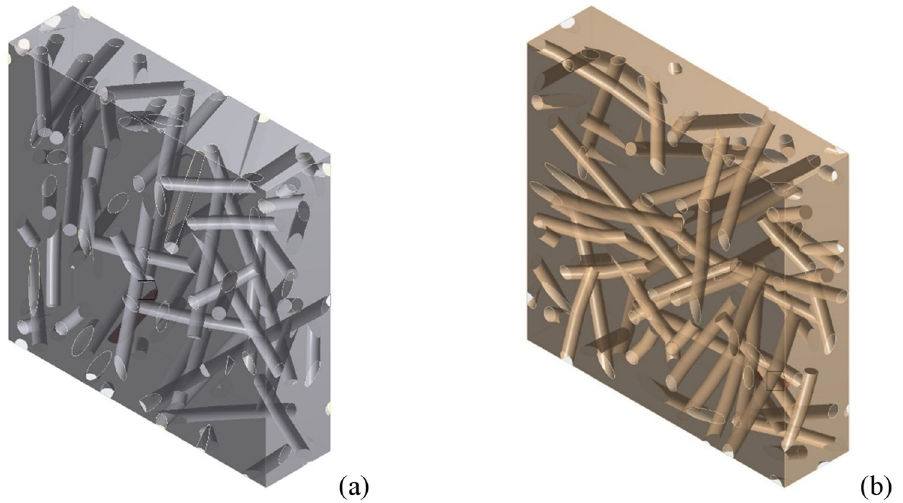
Figure 12. RVE of epoxy resin-short sisal fiber composites with V f = 0.1 and variable mean fiber curvature: ( a ) 0.75, ( b ) 1.